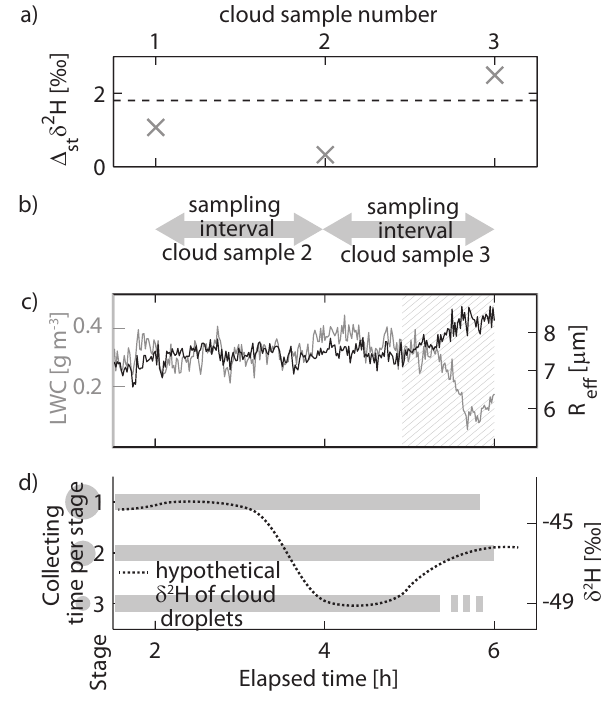
Fig. 5. Illustration of the collection artifact arising during the dissolution period of the cloud for event 11. (a) ∆ s t δ 2 H for all cloud samples of event 11 including the 1.8‰ threshold as a dashed line. (b) Sampling intervals of cloud sample 2 and 3 (1 is not shown). (c) Liquid water content (LWC) and effective radius ( R eff ) measured with the Particulate Volume Monitor (PVM-100). The dissolution period of the cloud is indicated as a hatched area. ( d , left axis) Collecting times (estimated from the measurements in panel (c) ) for the three different CASCC stages and ( d , right axis) hypothetical δ 2 H evolution in cloud droplets which could lead to the observed ∆ s t δ 2 H depicted in (a) . See Sect. 3.4 for detailed explanation.